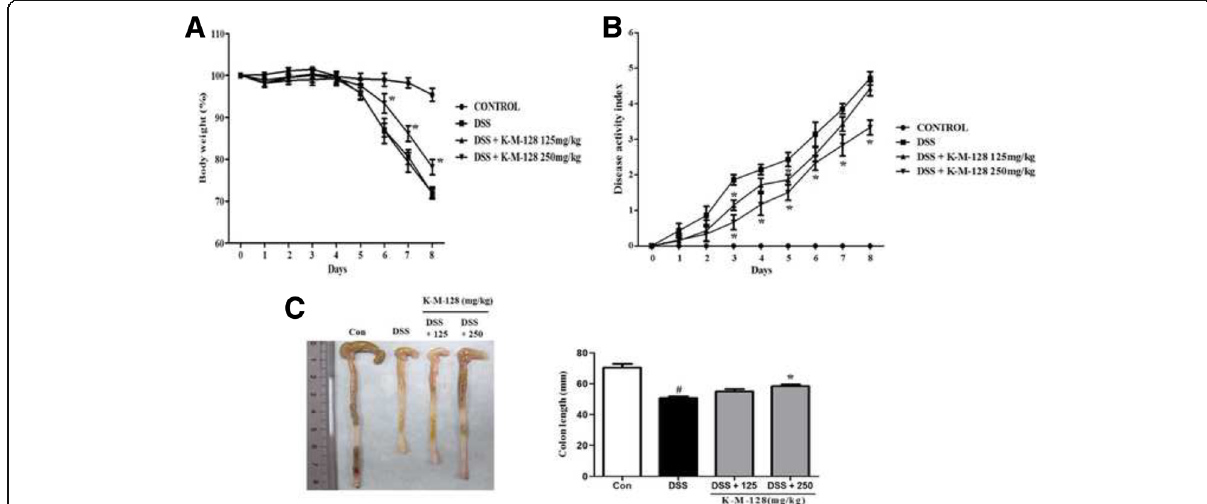
Fig. 1 The effects of KIOM-MA-128 on morphological changes in a DSS-induced colitis model. Mice were orally administered K-M-128 (125 or 250 mg/kg) before DSS treatment. The body weights ( a ) and DAI scores ( b ) were monitored before K-M-128 treatment during the experimental schedule. The colonic lengths ( c ) of mice were measured after the colons were isolated from the sacrificed mice. The results represent the mean ± SEM values of each mouse in the same group. # p < 0.05 versus the control group, * p < 0.05 versus the DSS-treated group